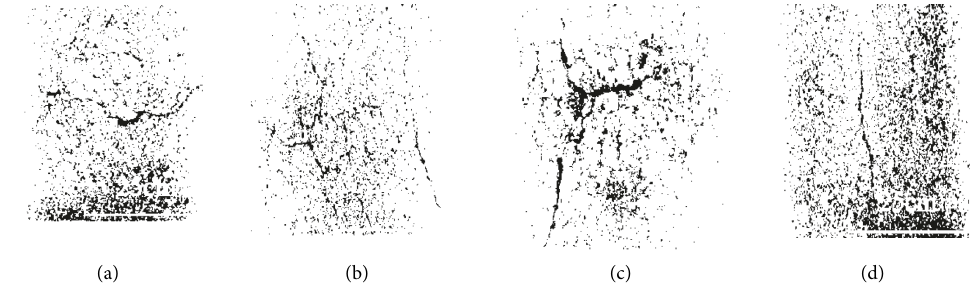
Figure 6: Binary processing part of green sandstone specimen partial enlarged view. (a) B -1. (b) C -1. (c) C -2. (d) C -3.